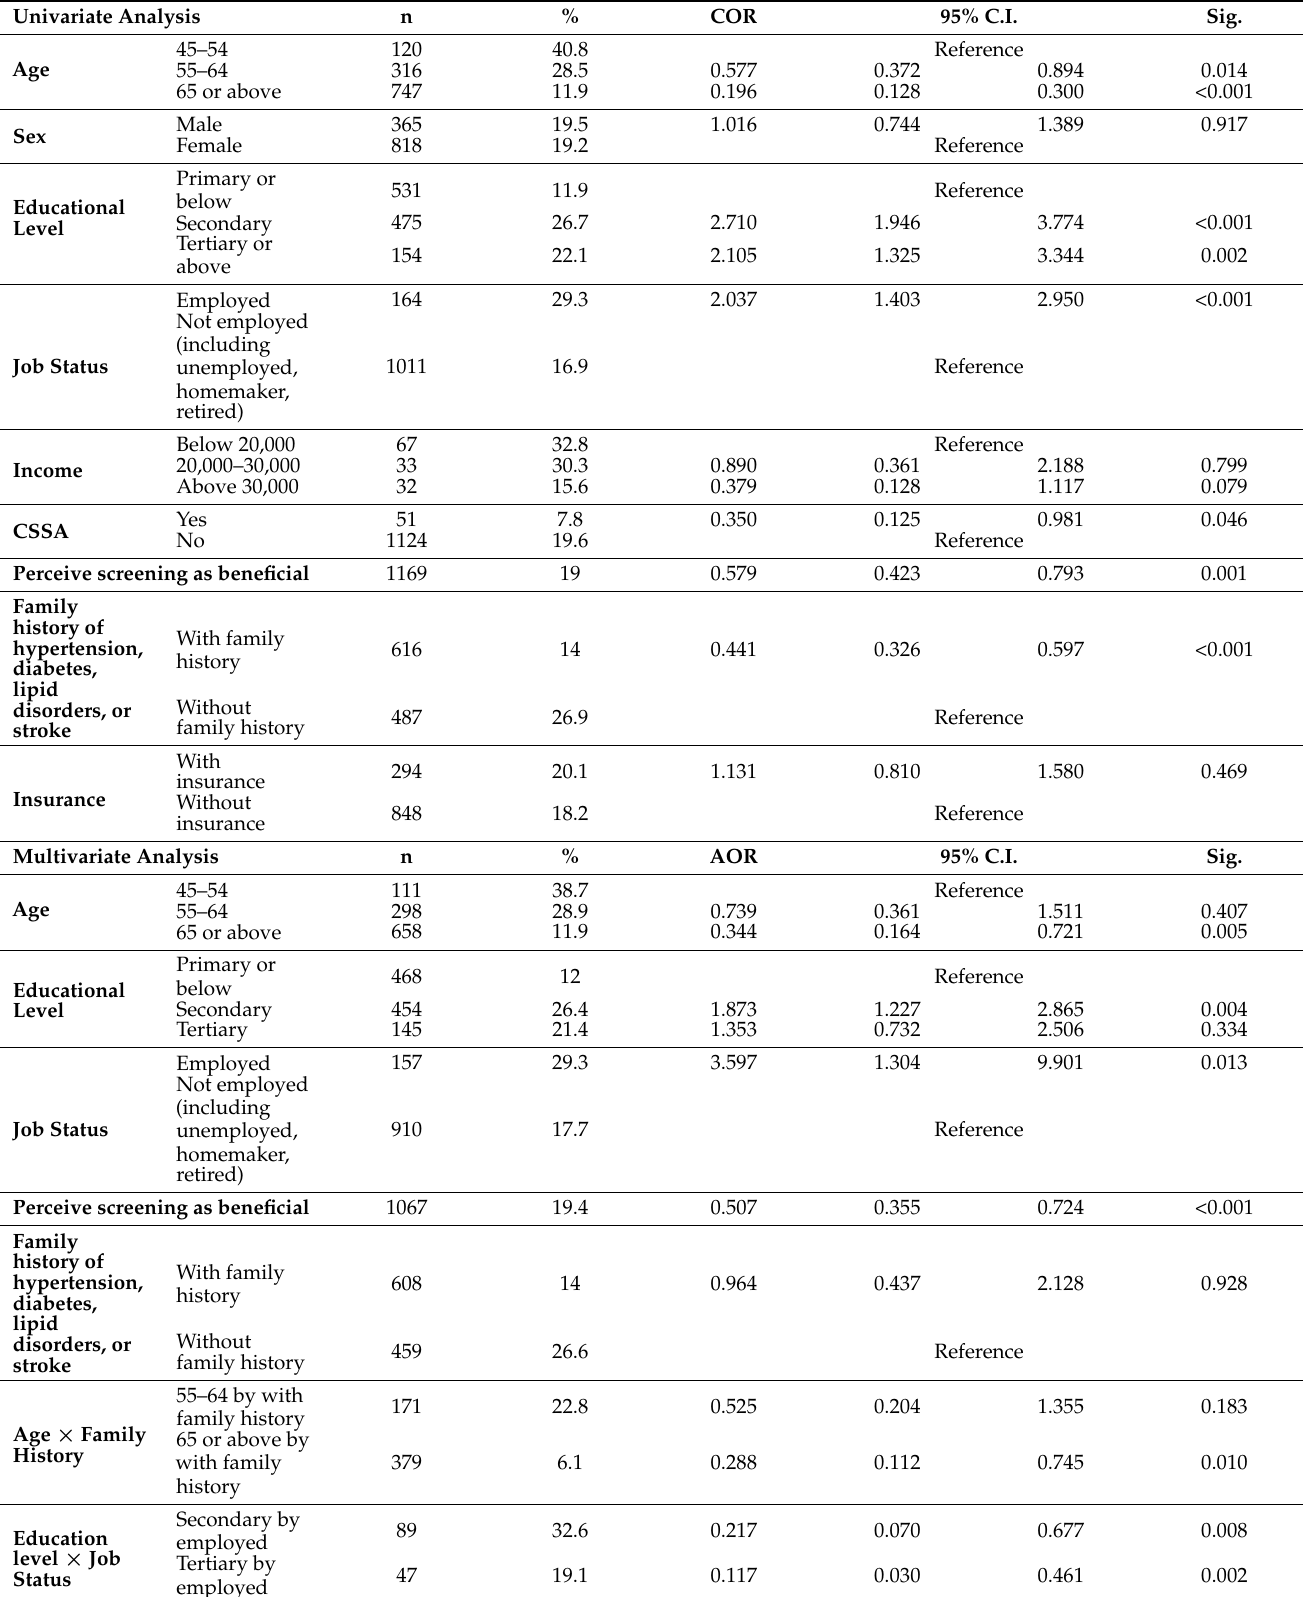
Table 3. Factors associated with not screening for at least two